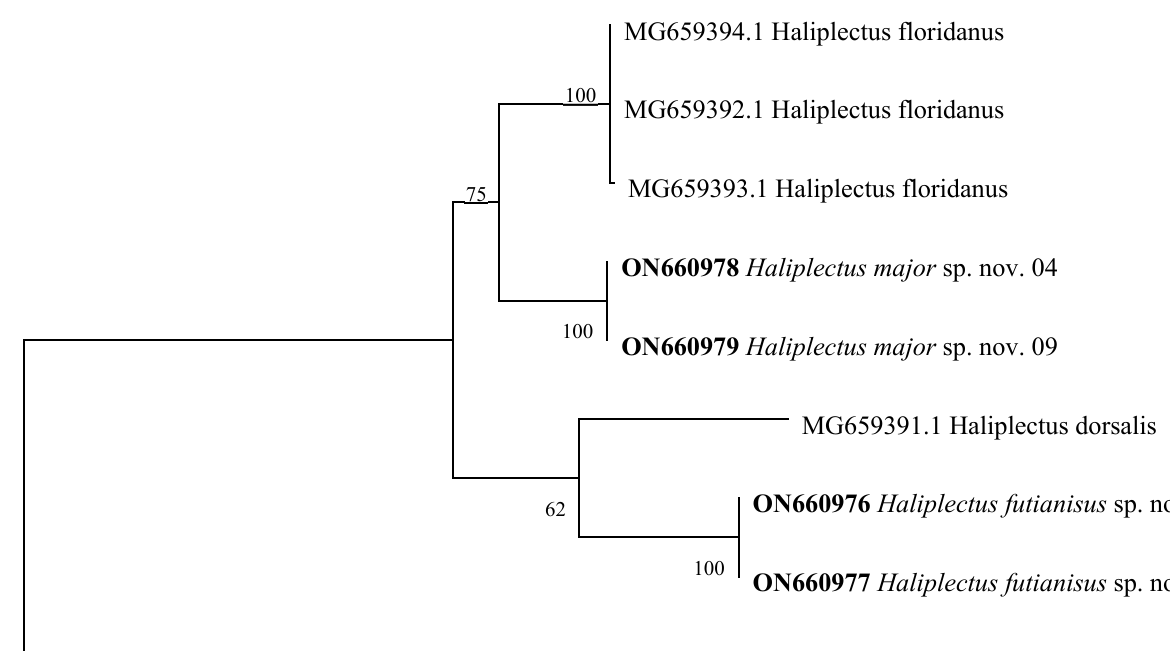
Figure 6. Maximum likelihood tree based on a 310 bp region of the COI gene. The sequences highlighted in bold are from this study. Numbers above/below the branches indicate branch support based on 1000 bootstrap replicates.